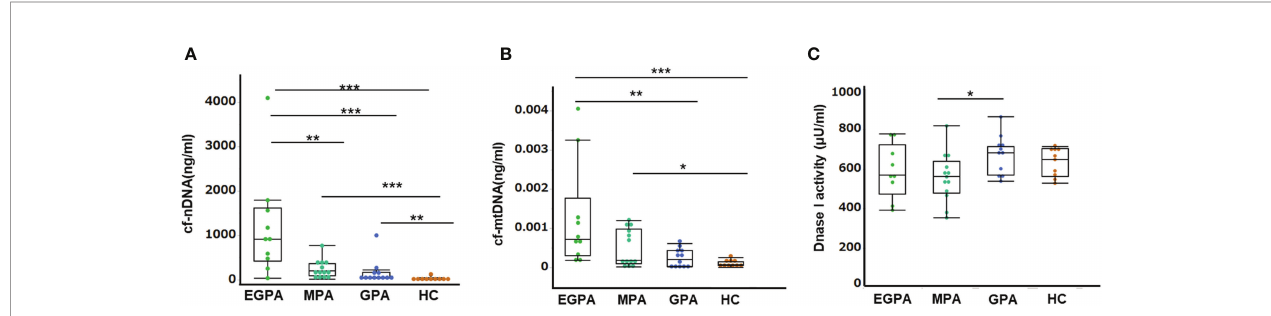
FIGURE 1 | Serum concentrations of cf-nDNA and cf-mtDNA in immunosuppressive therapy-naïve patients with AAV. Concentrations of cf-nDNA in HC and patients with EGPA, MPA, and GPA before immunosuppressive therapy measured by qPCR using primer sets for the 115-bp ALU repeats. (B) Concentrations of cf- mtDNA in HC and patients with EGPA, MPA, and GPA before immunosuppressive therapy measured by qPCR using primer sets for 79-bp gene fragment of mitochondrial 16s-RNA. (C) Serum DNase1 activity before treatment measured by fl uorescence spectrophotometry. One unit of DNase1 was de fi ned as the amount of enzyme that cleaved 1.0 μmol of DNA probe per minute. EGPA: n=10, MAP: n=13, GPA: n=12, HC: n=10, * P < 0.05, ** P < 0.01, *** P < 0.001, Mann – Whitney U test.